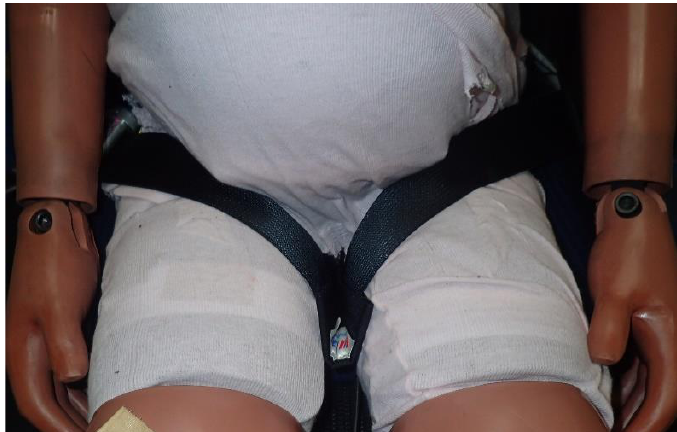
Figure 3. Test setup of the MAMA-2B dummy with the lap belt passed across both thighs and anchored between them using an extra restraint device.